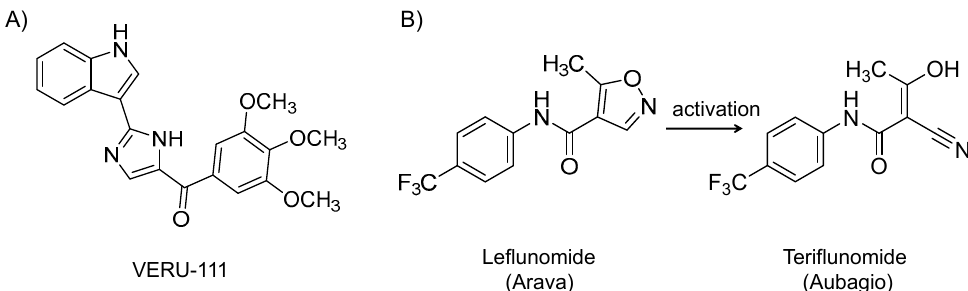
Figure 8. ( A ) The chemical structure of investigational drug VERU-111. The drug exhibits broad antiviral activity because it disrupts the intracellular transport of viruses, including SARS CoV-2, along microtubules, which is critical for viruses to cause infection. It also promotes strong anti-inflammatory e ff ects. ( B ) The chemical structures of leflunomide and its active metabolite teriflunomide. Their potential therapeutic values in COVID-19 patients are attributed to antiviral e ff ects by dihydroorotate dehydrogenase inhibition and to anti-inflammatory e ff effects by dihydroorotate dehydrogenase inhibition and to anti-inflammatory effects.